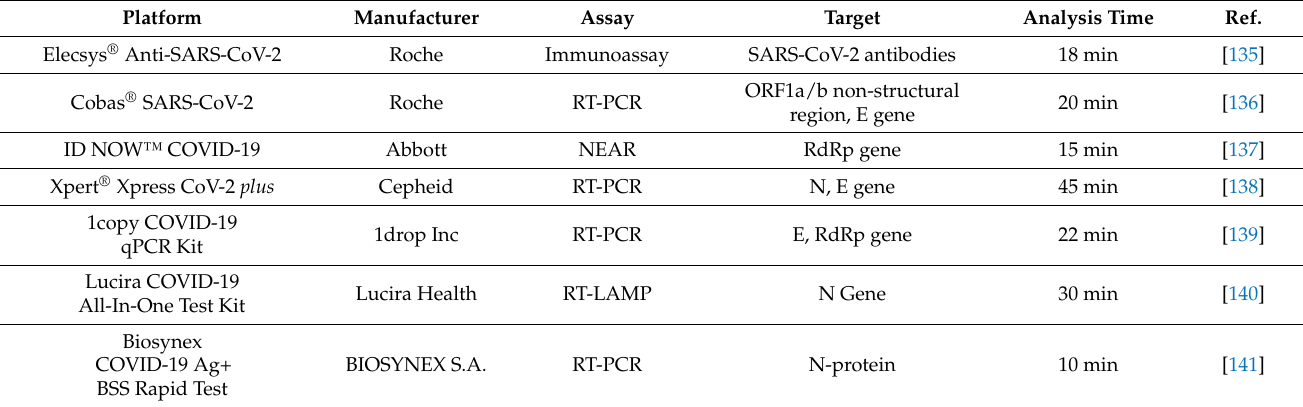
Table 2. Commercialized microfluidic products for COVID-19